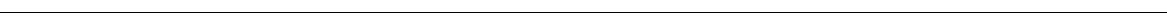
Fig. 2 Elevated rates of mossy fi bre synaptic input during whisking bouts. a Whisker position ( orange ; upward de fl ection indicating protraction) and simultaneously recorded holding current from GC-voltage clamped at − 70 mV ( black ; downward de fl ections correspond to inward currents). b Top left : whisker position from 10 representative whisking epochs (trials). Top right : corresponding GC holding current. Voltage-clamp sweeps have been smoothed for visual clarity. Bottom left : raw position traces ( orange ) and mean whisker position ( red line ; black : S.E.M.) for all trials ( n = 50 trials). Bottom right : mean holding current ( black line ; grey : S.E.M.) for all trials ( n = 50 trials). c Normalised histogram of EPSC amplitude for a single GC during quiet and whisking epochs. No signi fi cant change was observed between the two conditions ( P = 0.77, Kolmogorov – Smirnov test). d Normalised histogram of EPSC 20 – 80% rise-time for a single GC during quiet and whisking epochs. No signi fi cant change was observed between the two conditions ( P = 0.07, Kolmogorov – Smirnov test). e Normalised histogram of EPSC inter-current interval for a single GC during quiet and whisking epochs. The two distributions were signi fi cantly different ( P < 0.001, Kolmogorov – Smirnov test), with a larger proportion of short intervals during whisking. f Mean EPSC amplitude in periods of quiet and whisking for all GCs. No signi fi cant change was observed between the two conditions ( P = 0.45, Wilcoxon signed-rank test, n = 11). g Mean EPSC 20 – 80% rise-time in periods of quiet and whisking for all GCs. No signi fi cant change was observed between the two conditions ( P = 0.25, Wilcoxon signed-rank test, n = 11). h Mean EPSC rate in periods of quiet and whisking for all GCs. EPSC rate was signi fi cantly elevated during whisking epochs (*** P < 0.001, Wilcoxon signed-rank test, n =